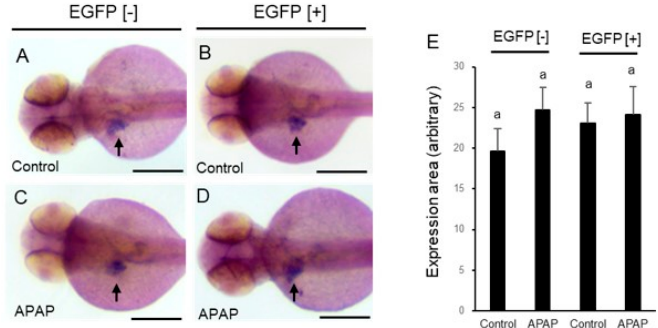
Figure 6. Effect of acetaminophen on hepatocyte differentiation in rat CYP2E1-TG larvae. EGFP fluorescence-negative (EGFP [ − ]) ( A , C ) and -positive (EGFP [+]) ( B , D ) F2 CYP2E1-transgenic larvae were exposed to 2.5 mM acetaminophen (APAP) from 48 hpf to 54 hpf. The larvae were fixed at 54 hpf for whole-mount in situ hybridization with a foxa3 probe, a marker for the liver primordium. All images ( A – D ) are of a dorsal view, and black arrows indicate the expression area of foxa3. Scale bars: 200 µm. Panel E indicates averaged areas of foxa3 expression ( n = 5–9). The “a” over each bar indicates that these values are not statistically different.